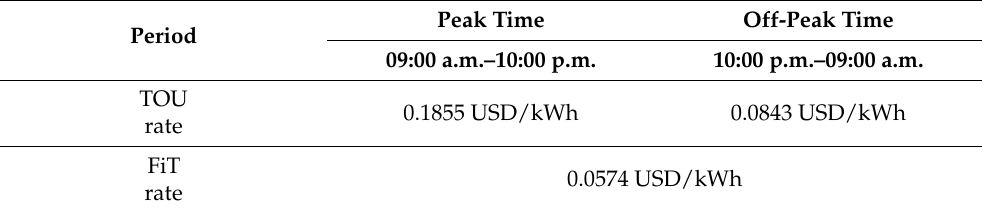
Table 2. TOU and FiT tariffs of Thailand.